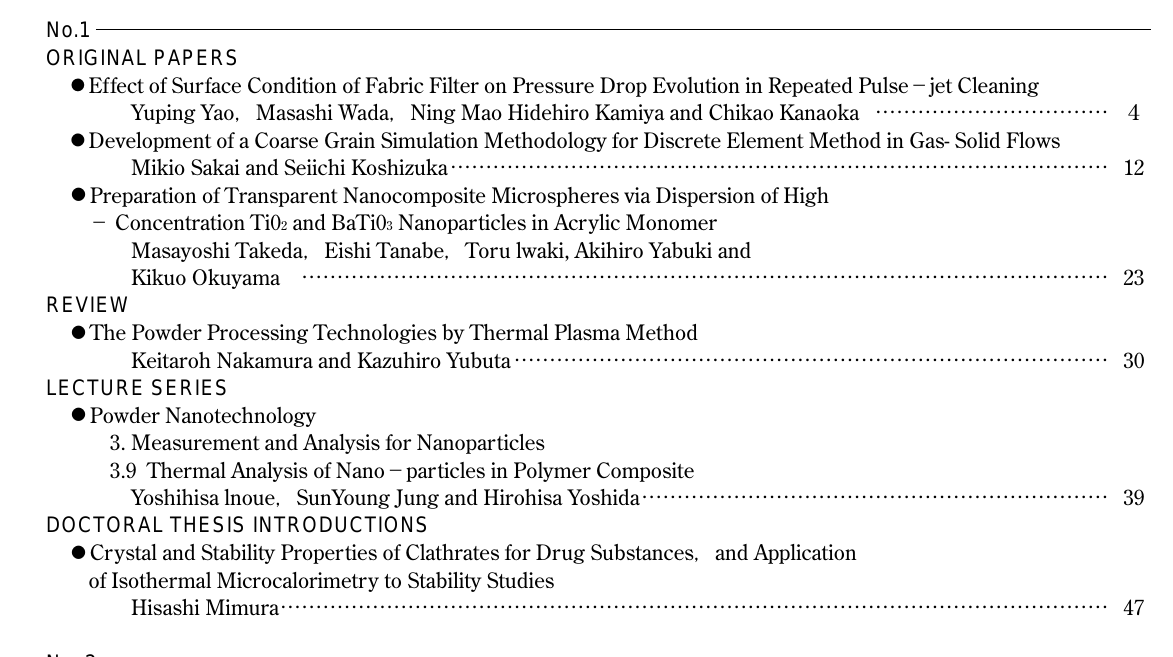
・ Effect of Surface Condition of Fabric Filter on Pressure Drop Evolution in Repeated Pulse − jet Cleaning Yuping Yao ， Masashi Wada ， Ning Mao Hidehiro Kamiya and Chikao Kanaoka …………………………… ４ (cid:12255) Development of a Coarse Grain Simulation Methodology for Discrete Element Method in Gas- Solid Flows ● Preparation of Transparent Nanocomposite Microspheres via Dispersion of High − Concentration Ti0 2 and BaTi0 3 Nanoparticles in Acrylic Monomer